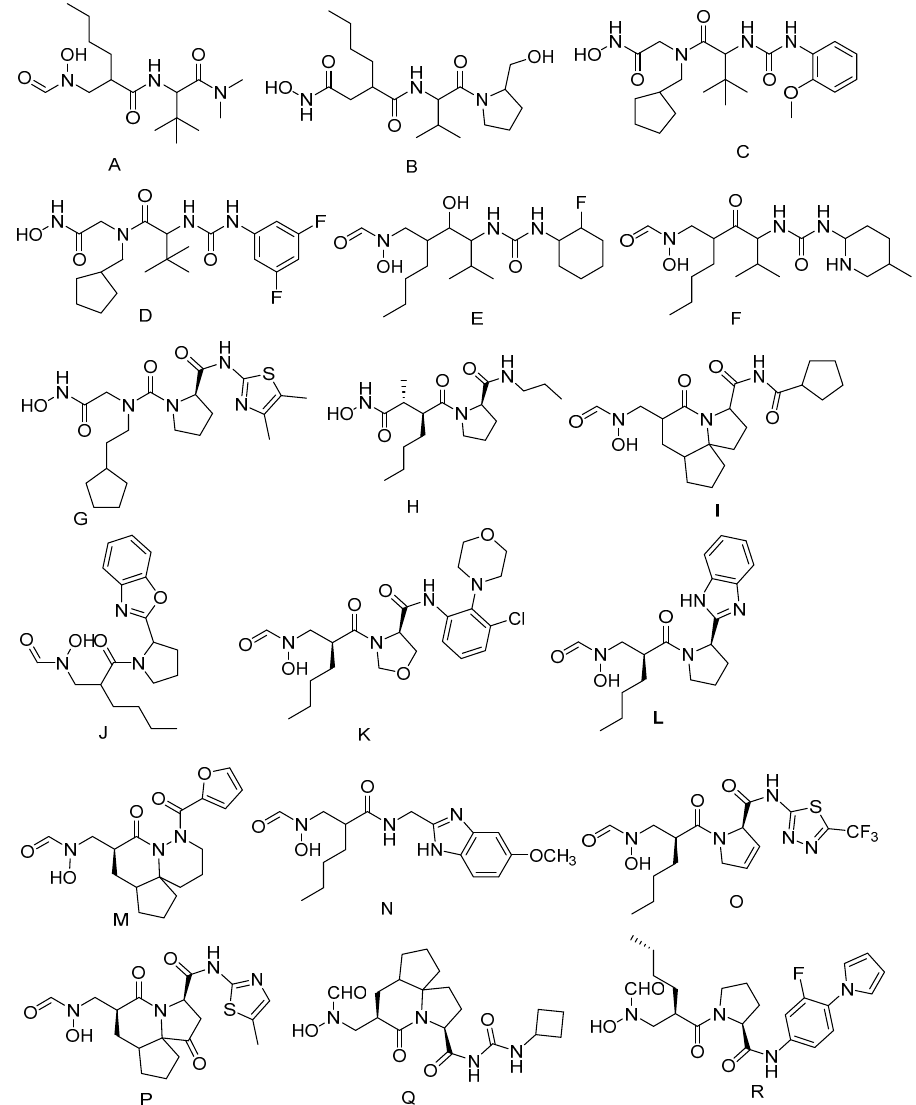
Figure 5. Chemical structures of known PDF inhibitors used for the generation of pharmacophore models.